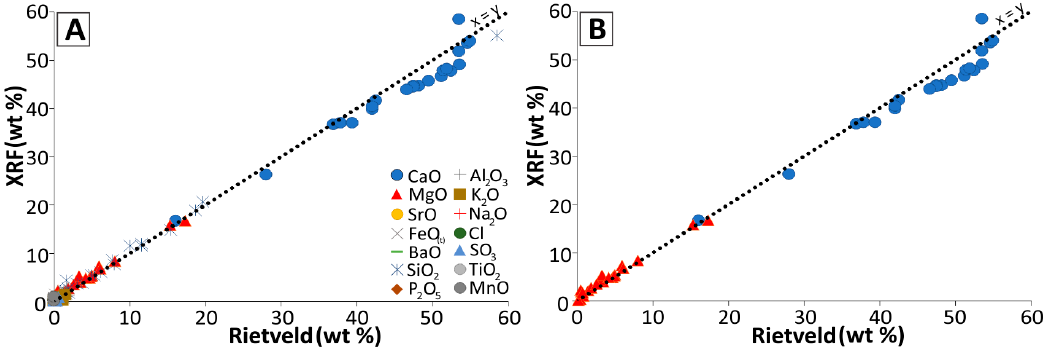
Figure 4. Conciliation of the chemical composition derived from mineral quantification by the Rietveld method (XRD) against XRF analyses (wt %). ( A ) Data for all analyzed elements. ( B ) Data only for Ca and Mg. Data in Tables S2 and S3.